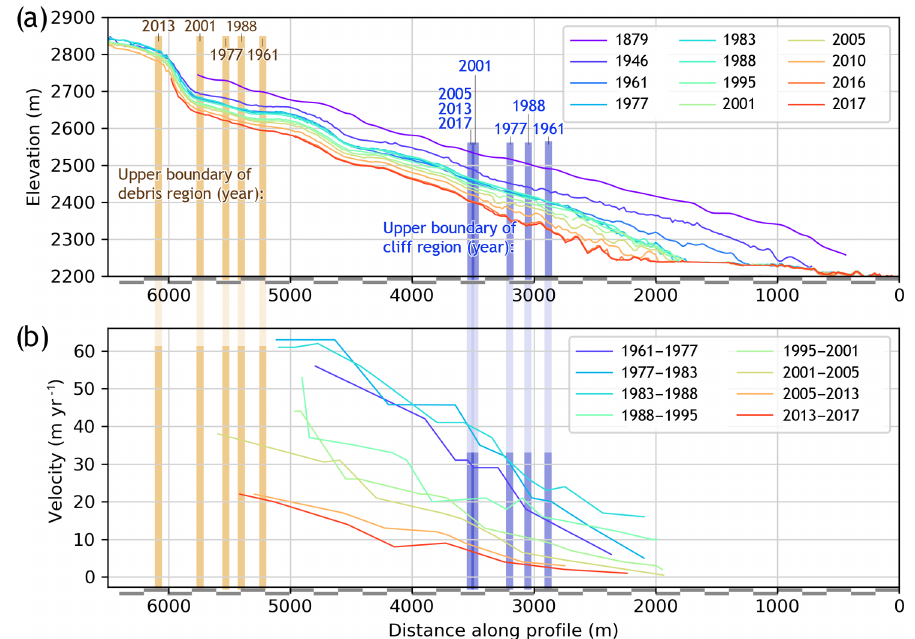
Figure 12. (a) Central elevation profiles over the glacier tongue from the 19th century until 2017; the red line (2017) marks the former glacier bed from 0 to ∼ 2000m along the profile; the rugged lower part of the lines is shaped by ice cliffs and flow channels. (b) Surface flow velocities from the 1960s until 2017 along the same profile; velocities were highest during the positive mass balance period in the 1970s and 1980s; the lowest part of the tongue is almost stagnant (2017). Vertical brown and blue bars show the upper boundaries of the debris-covered area and the ice-cliff zone, respectively; both boundaries have interrupted their up-glacier trend between 1977 and